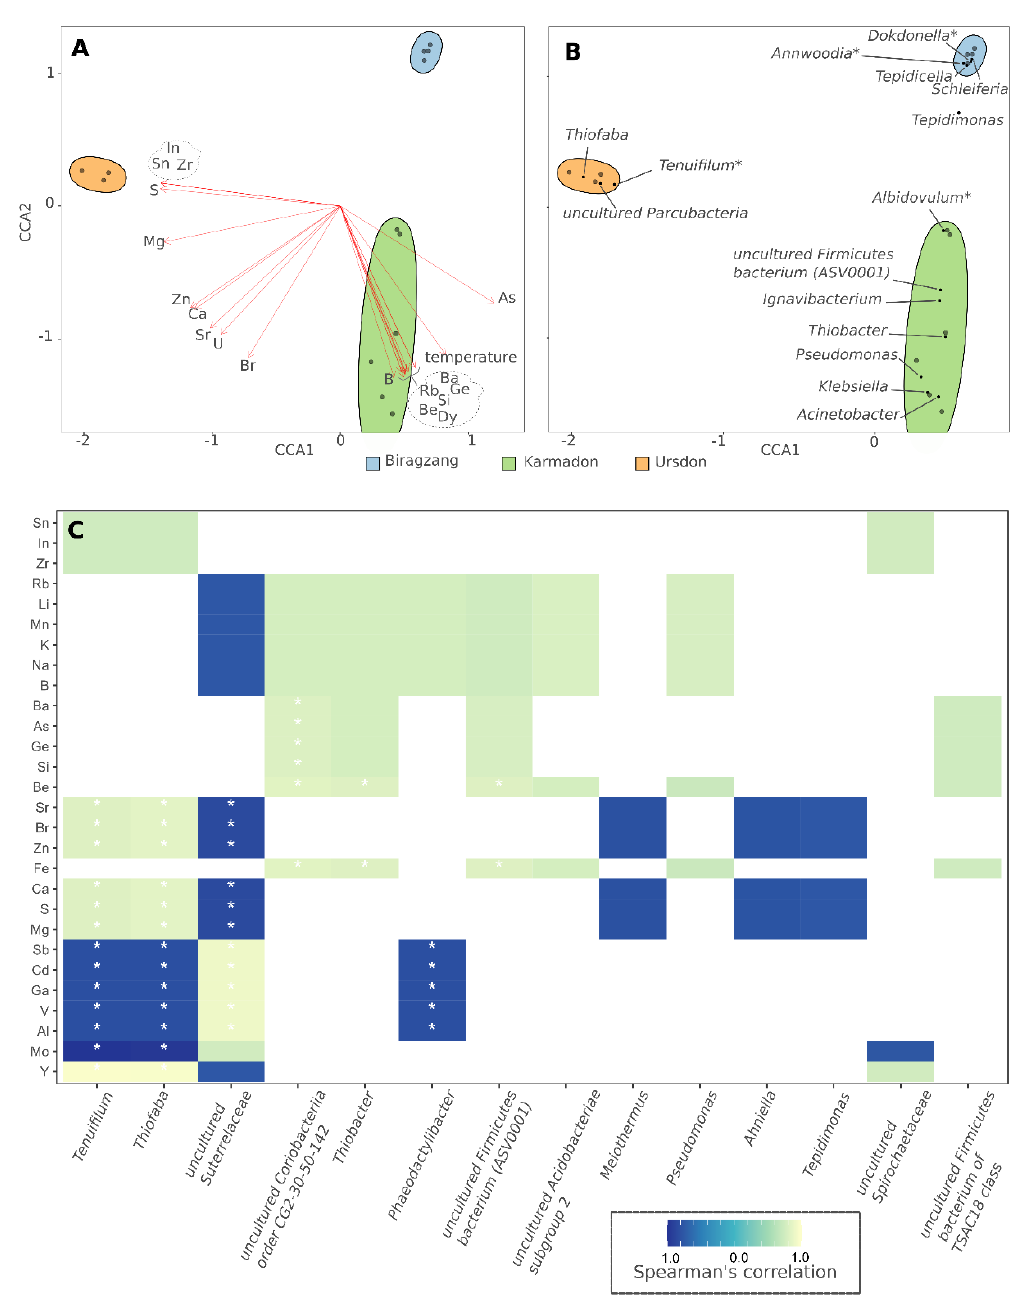
Figure 4. Correlation of microbial community composition with environmental parameters: ( A ) Environmental variables fitted to CCA plot by envfit function of vegan package; ( B ) Major taxa shown on CCA plot; ( C ) Heatmap of individual correlations of the most abundant taxa with elemental composition. Taxa-element pairs, which showed the correlation p -value less than 0.05, are marked with asterisks.